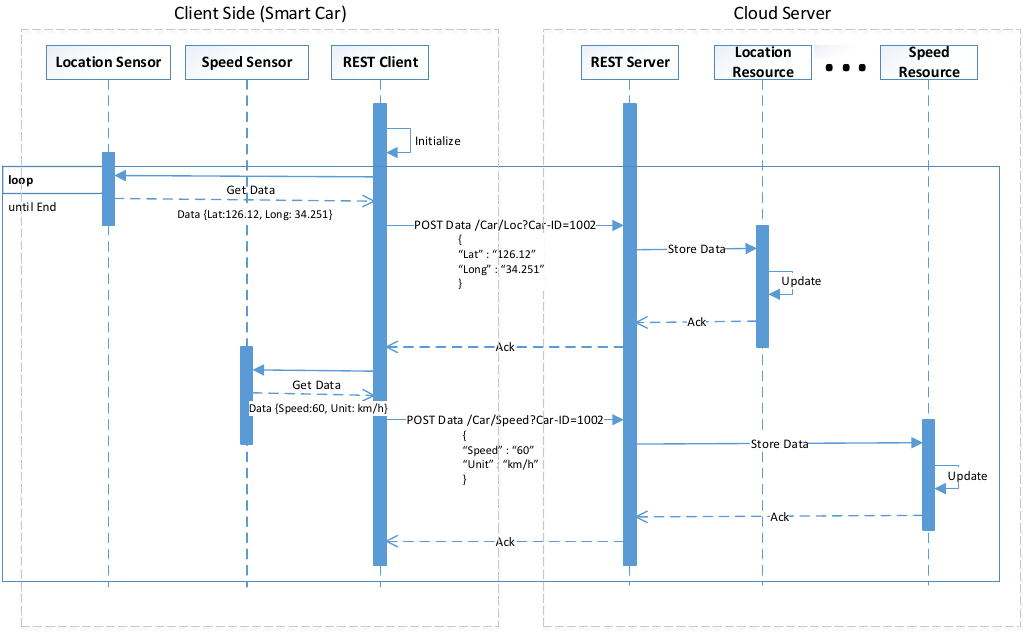
Figure 3. Smart car example scenario with multiple requests from IoT device to POST data to multiple end-points using REST